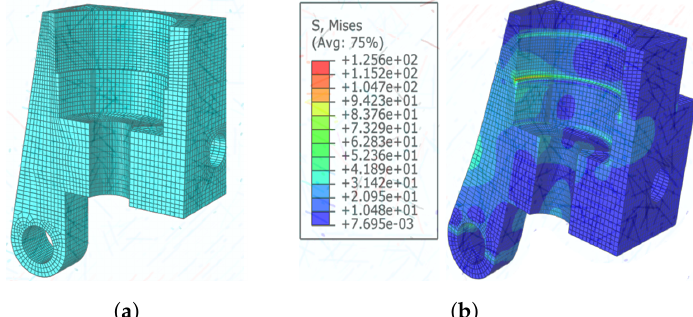
Figure 8. A simplified model associated with a suitable mesh size ( a ) and stress analysis ( b ) of the hydraulic block. The stress analysis was performed using